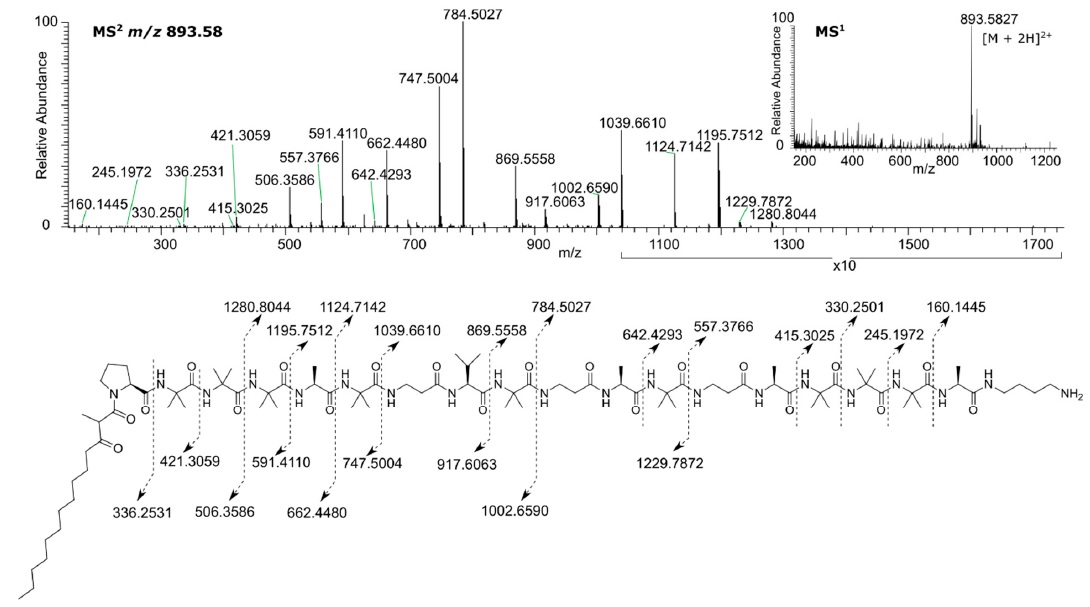
Figure 3. HRMS for sphaerostilbellin A ( 1 ).